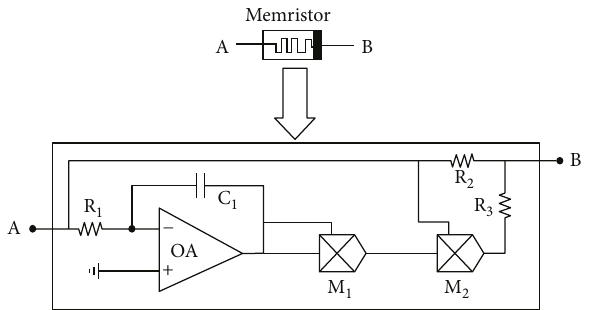
Figure 5: The fully integrated memristor.